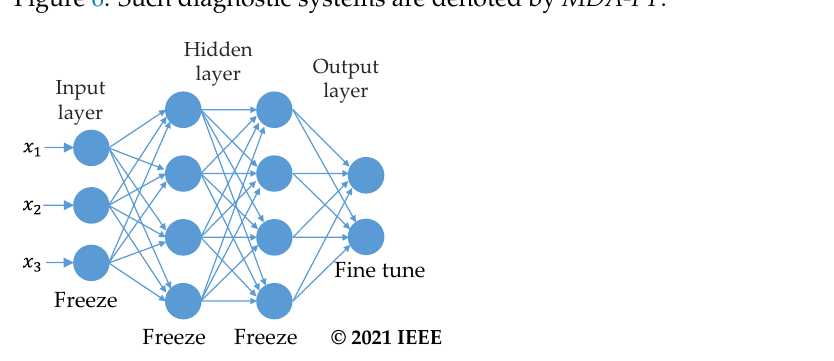
Figure 6. Transfer learning using fine-tuning [30,31].